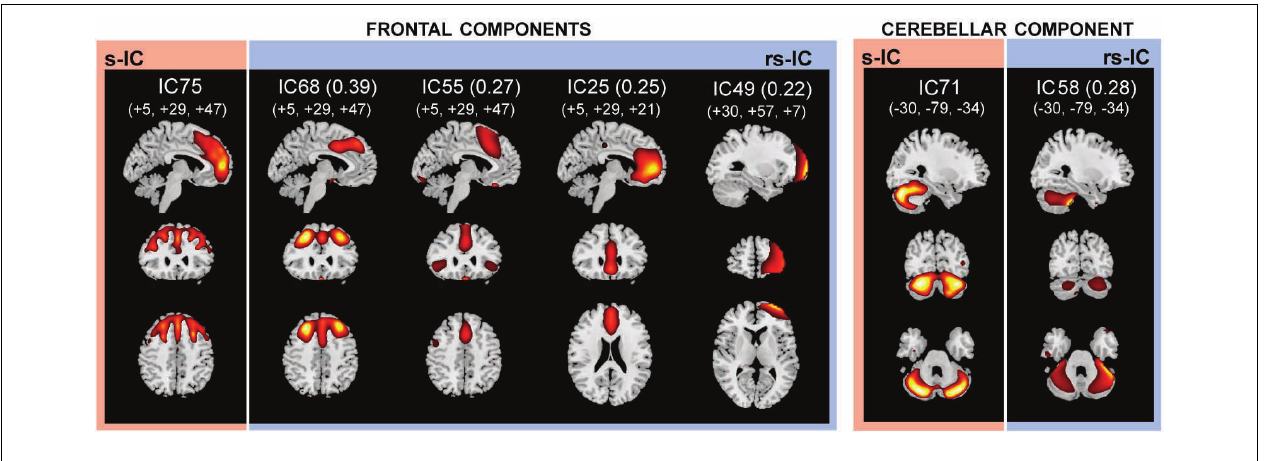
peak activation, indicated as ( x , y , z ) coordinates in MNI space.When structural components are paired with a single functional component, the functional component is displayed at the same slices. If a structural component corresponds to several fMRI components, functional components may be displayed at different coordinates that best represent their